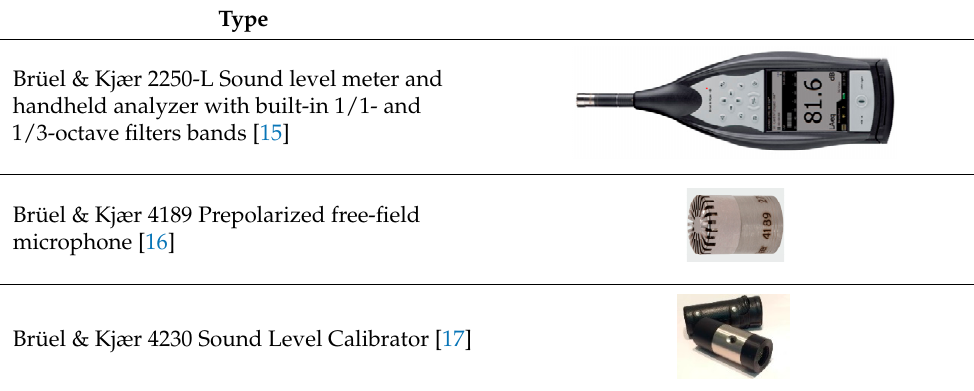
Table 1. Equipment used for noise measurement.